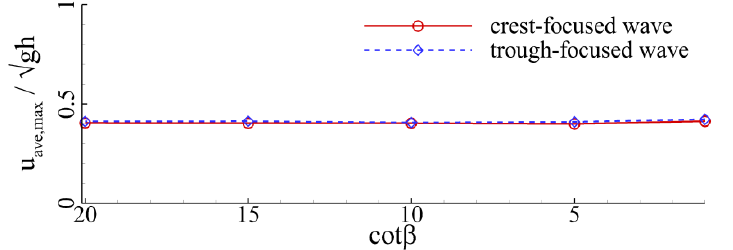
Figure 52. Local maximum depth-averaged velocity at the reef crest versus the backreef slope.